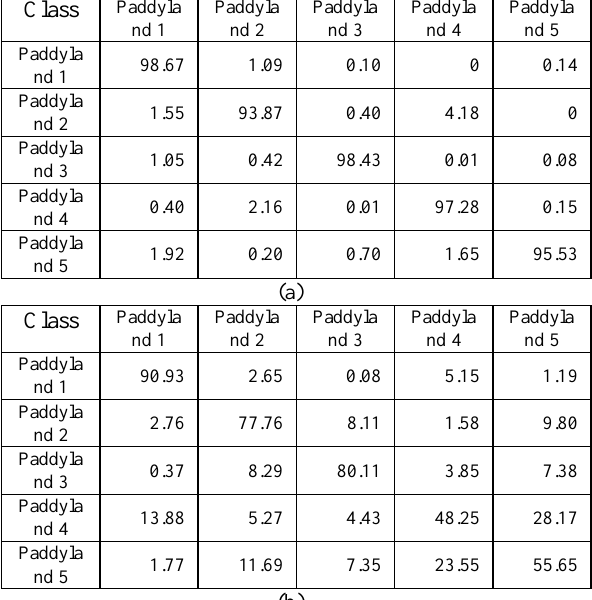
TABLE 6. Confusion matrix of SVM and BPNN, (a) Confusion matrix of SVM. (b) Confusion matrix of